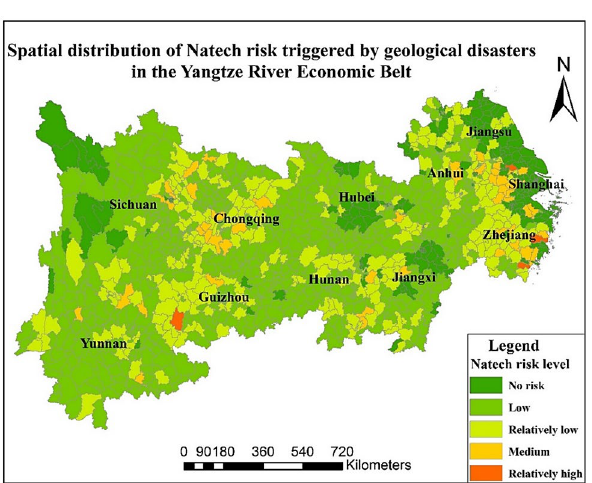
Figure 4. Distribution of Natech risk triggered by geological disasters in the YREB. Map is produced using ArcGIS 10.2 (http:// www. esri. com/ softw are/ arcgis/ arcgis- for- deskt